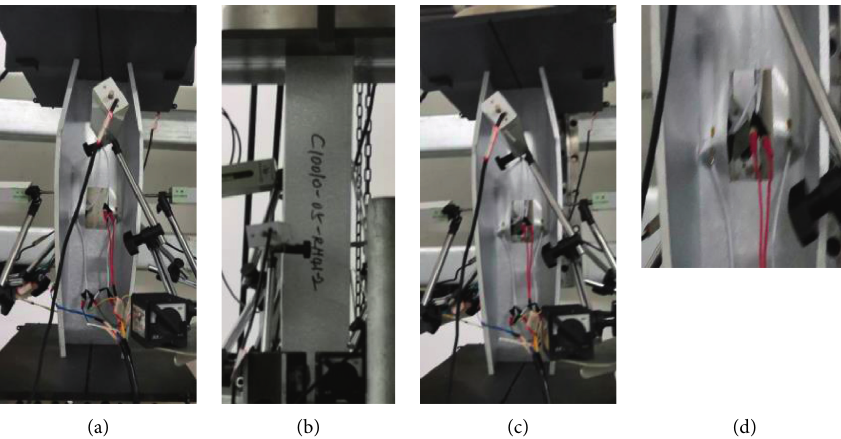
Figure 10: Buckling mode of specimen C10010-05-RH4-1. (a) Local buckling in web +distortional buckling. (b) Local buckling in the flange. (c) Plastic crush. (d) Local buckling of the plate strip adjacent to holes.